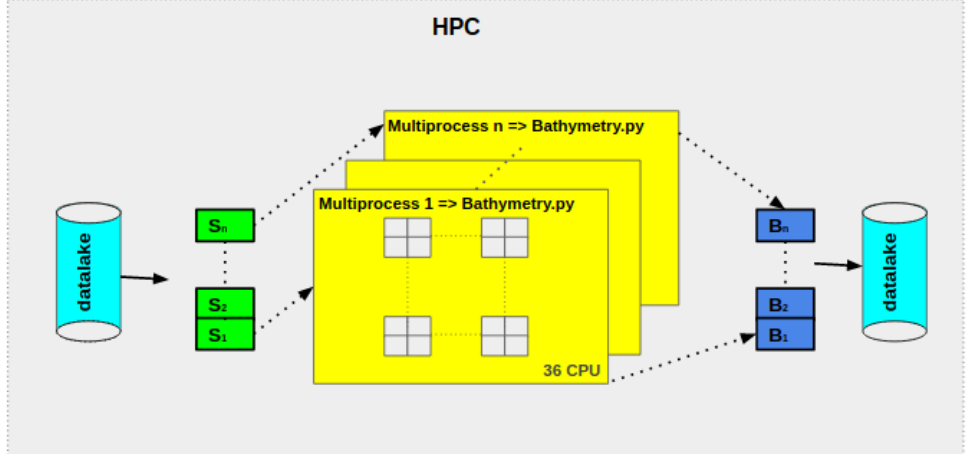
Figure 4. Schematic overview of a HPC architecture. From the right to the left: loading of the data from the datalake Sentinel-1, 2, ..., n. Then in each node (the yellow box) the image is split into 36 sub-images that are treated in parallel. Each output is merged and then saved in the datalake.